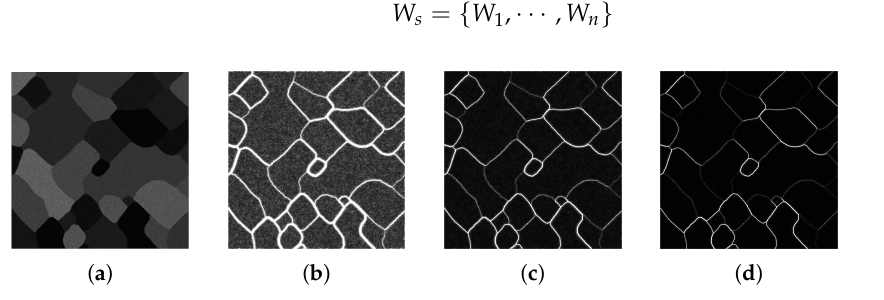
Figure 3. Effect of γ on strong and weak edges: ( a ) simulated SAR image. ( b – d ) γ = {3, 9, 15}. The primary edge fusion algorithm in the scale space is described as